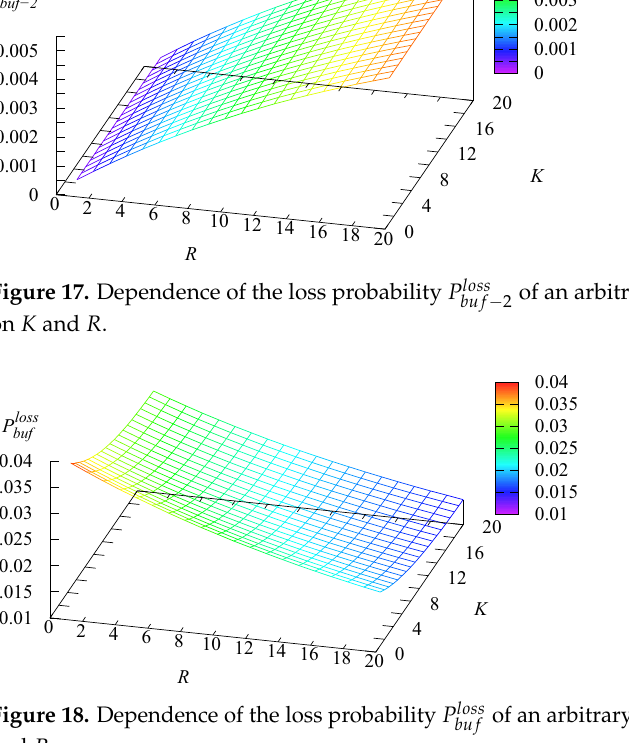
of an arbitrary request from the main buffer on K buf